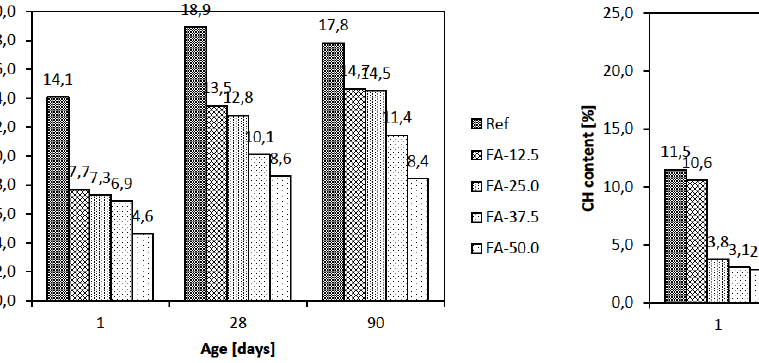
Figure 7: Development of hydrate water in pastes with blast furnace slag addition in time.